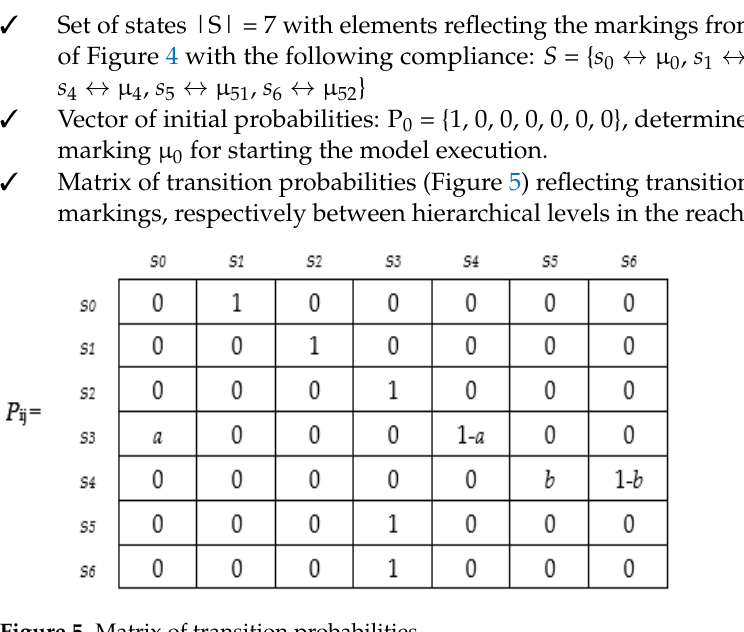
( b ) Figure 6. Definition of the model as a SPN. ( a ) Graph of the states of the Markov chain (graph definition); ( b ) stochastic analytical model.